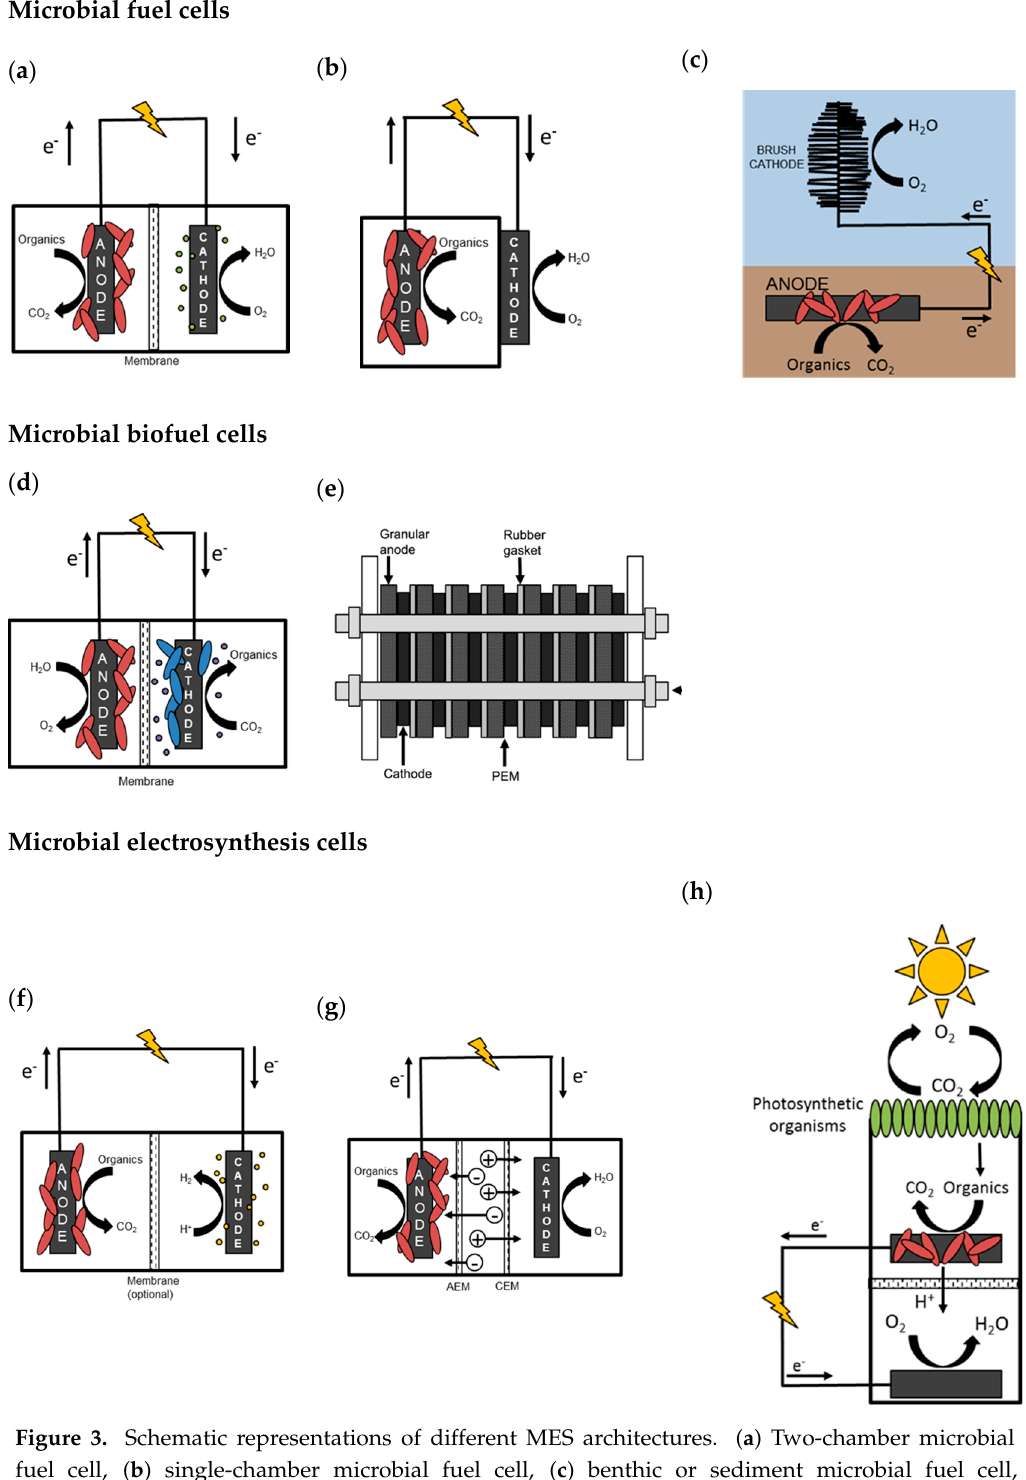
Figure 3. Schematic representations of different MES architectures. ( a ) Two-chamber microbial fuel cell, ( b ) single-chamber microbial fuel cell, ( c ) benthic or sediment microbial fuel cell, ( d ) microbial electrolysis cell, ( e ) stacked microbial fuel cell, ( f ) MEC synthesizing organic compounds, ( g ) desalination cell, ( h ) representative microbial solar cell. Images adapted from references [1,2,15].